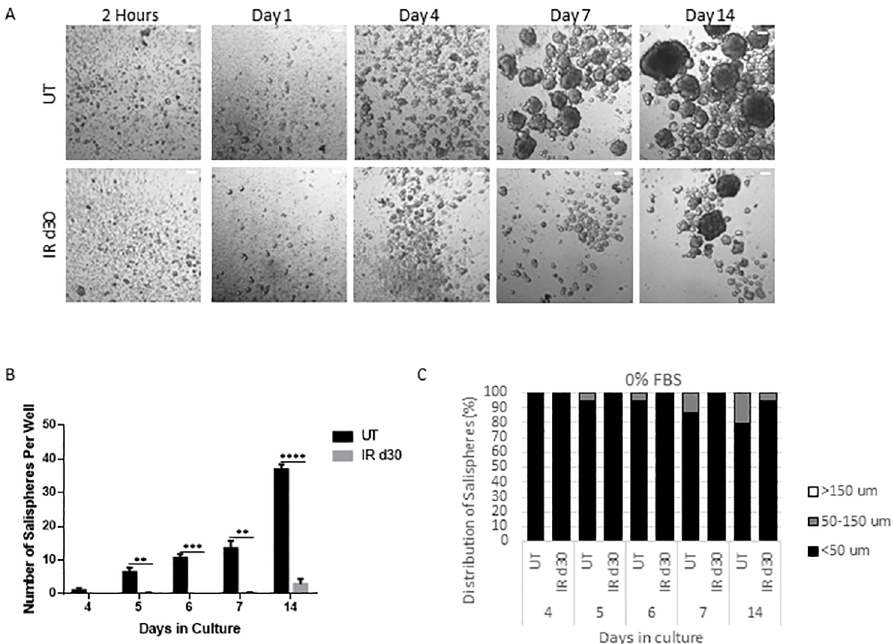
Fig 1. Sphere-forming efficiency decreases following radiation. A single 5 Gy dose of radiation (IR d30) was given to 4–6 week old female FVB mice and parotid glands were collected 30 days following radiation for sphere formation assay. Representative bright field images of salispheres grown from untreated control (UT) and irradiated (IR d30) glands in serum-free media at different time points in culture (A). Number of salispheres was quantified per 6 wells from 3 primary cell preparations per treatment group at days 4, 5, 6, 7, and 14 in culture and expressed as average ± SEM (B). Representative graphs showing the distribution of salisphere sizes among all the salispheres counted from one UT and IR d30 primary sphere preparation (C). P values were obtained with 2-sided unpaired t-test (n = 3), (cid:3)(cid:3) p < .01, (cid:3)(cid:3)(cid:3) p < .001, (cid:3)(cid:3)(cid:3)(cid:3) p < .0001. Scale bar = 50 μ m.